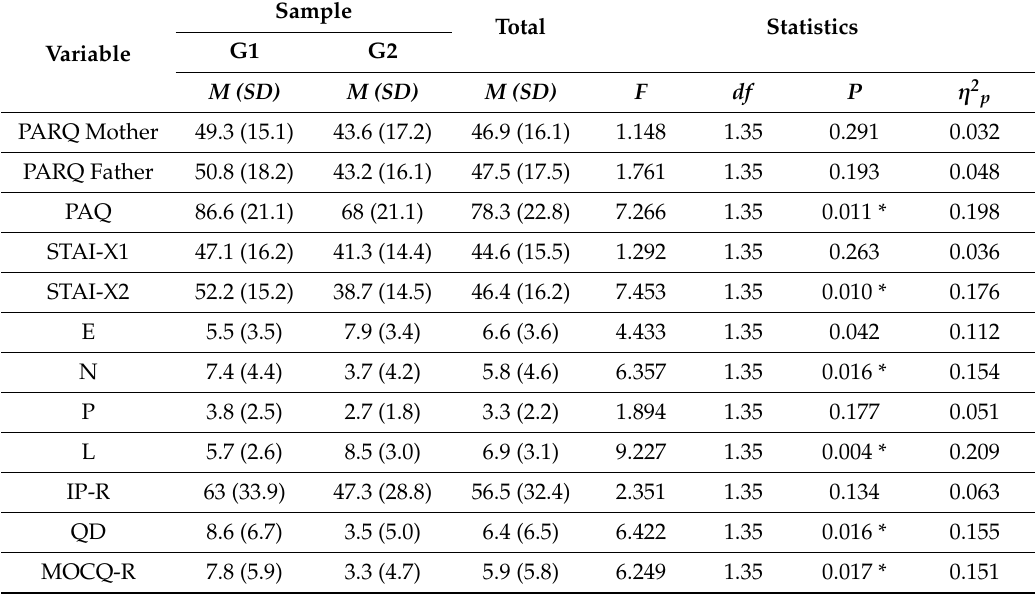
Table 3. One-way ANOVA on the Major Study Variables as a function of the age of appearance of their first ABDL